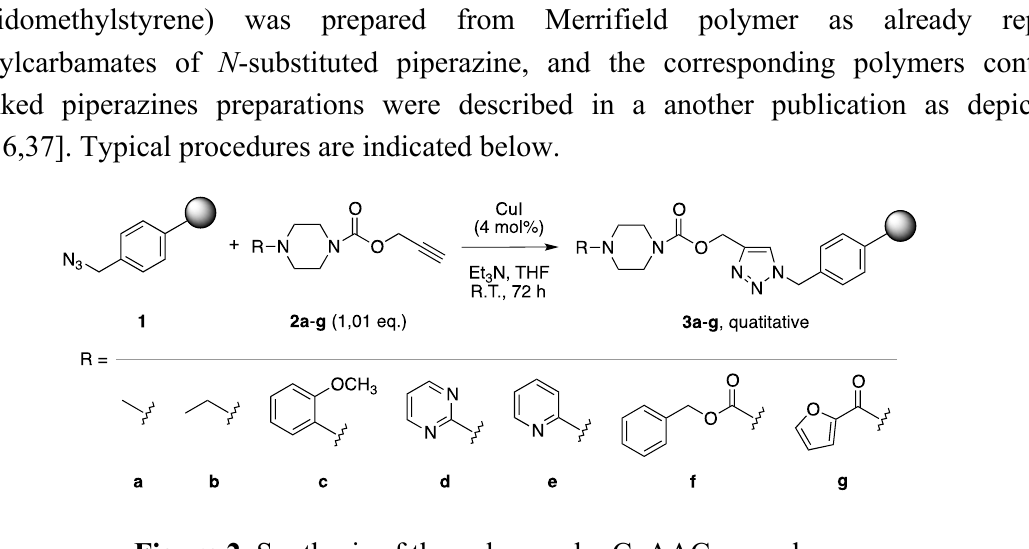
Figure 2. Synthesis of the polymers by CuAAC